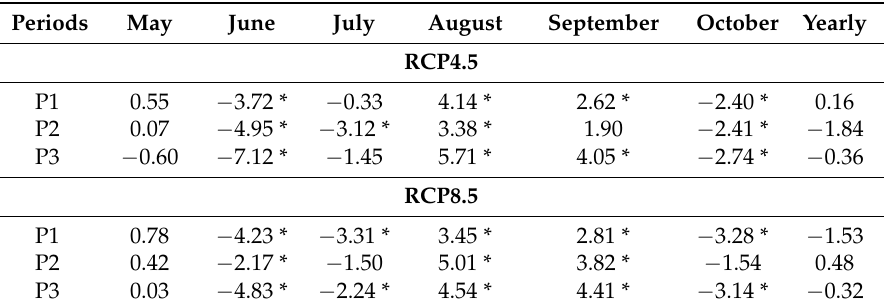
Table 3. Results of student’s t-test for rainfall